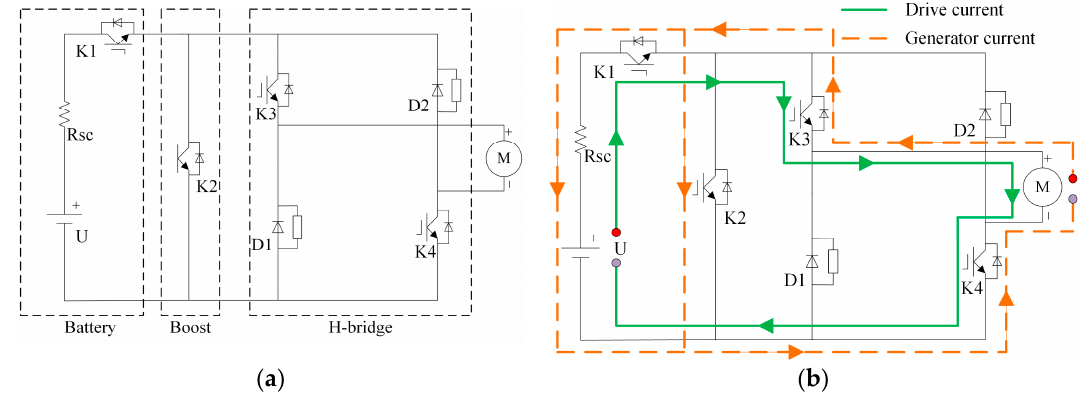
Figure 6. Power convertor circuit, ( a ) composition, ( b ) current flow.